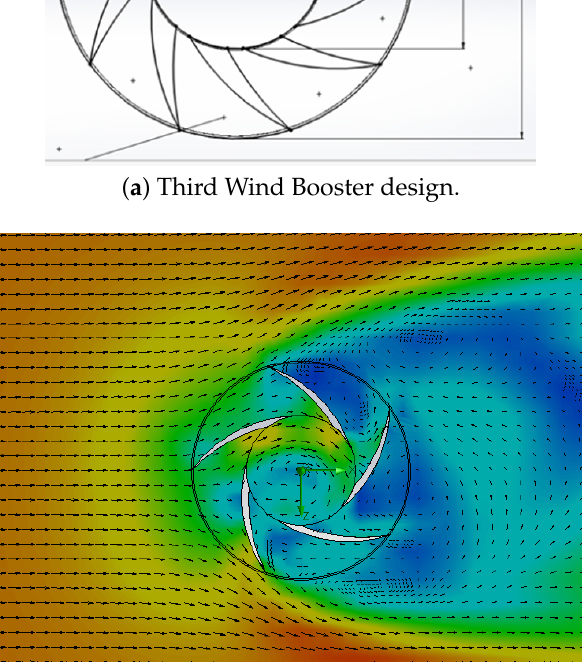
Figure 9. Third Wind Booster